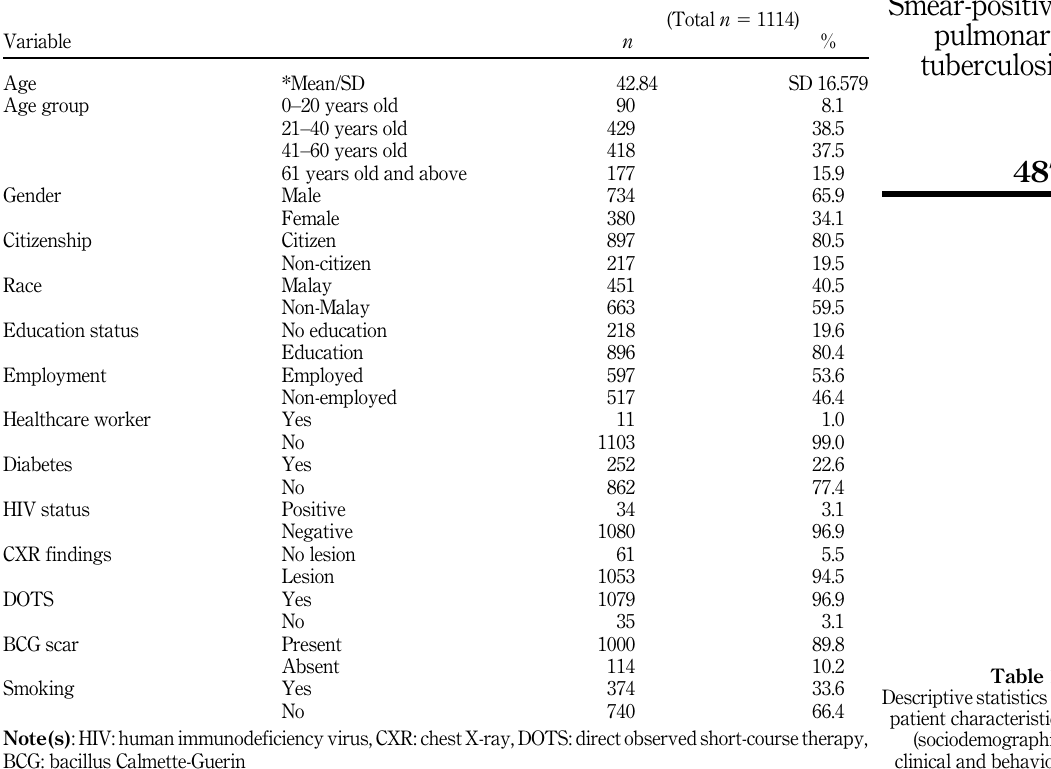
Table 1. Descriptivestatisticsof patient characteristics (sociodemographic,